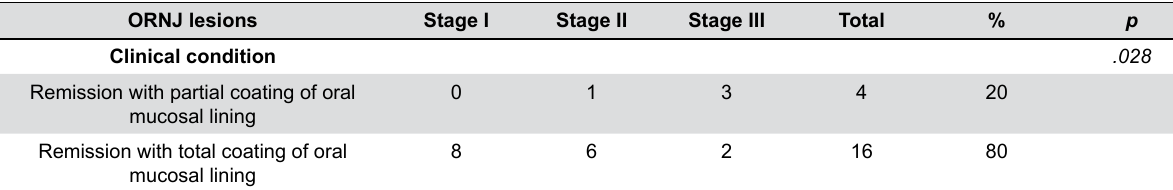
Table 3- LLLT and aPDT clinical outcomes on ORNJ lesions